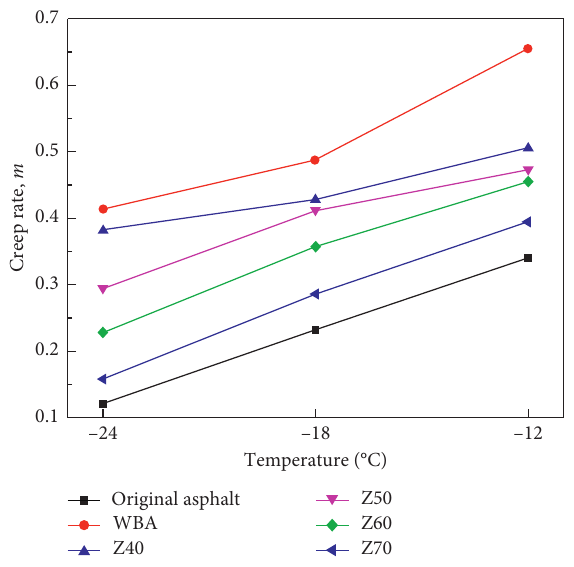
Figure 9: Creep rate m at different